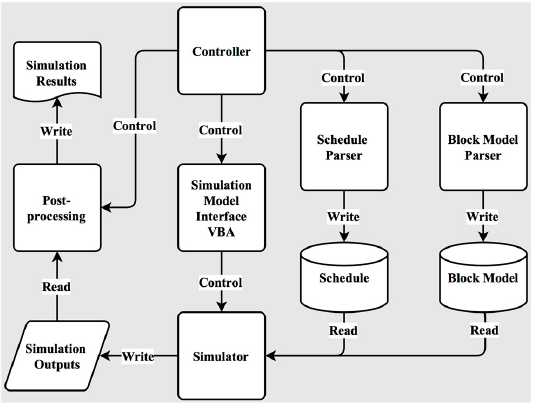
Figure 11. Simulation platform diagram.